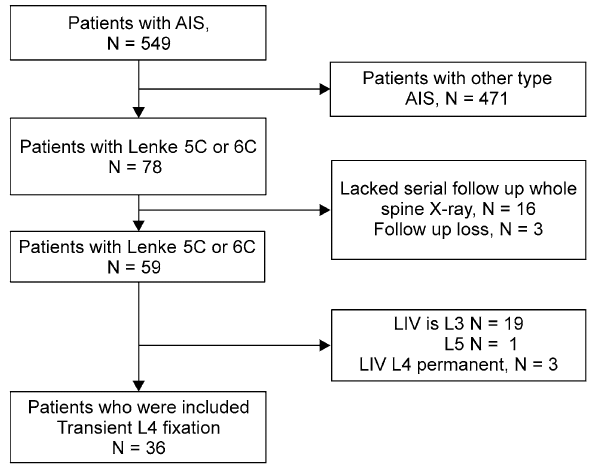
Figure 1. Study flowchart. A total of 549 cases of adolescent idiopathic scoliosis (AIS) that underwent surgical treatment between March 1996 and December 2017 in our hospital were reviewed. Of these, 78 cases